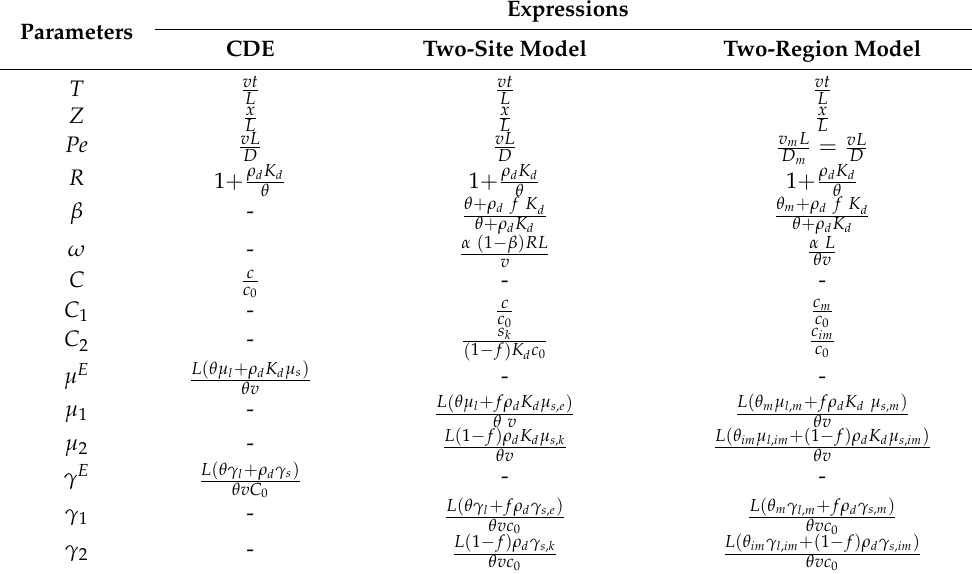
Table 3. Dimensionless parameters for the CDE, two-site, and two-region models (adapted from [42]). Expressions Parameters CDE Two-Site